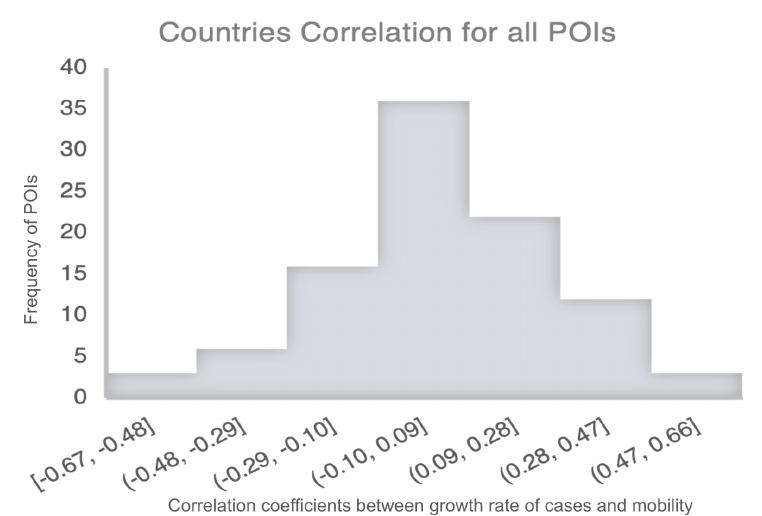
Figure 6. Histogram showing the frequency of the measured correlation coefficients between the growth rate of cases and mobility for all the POIs in all 14